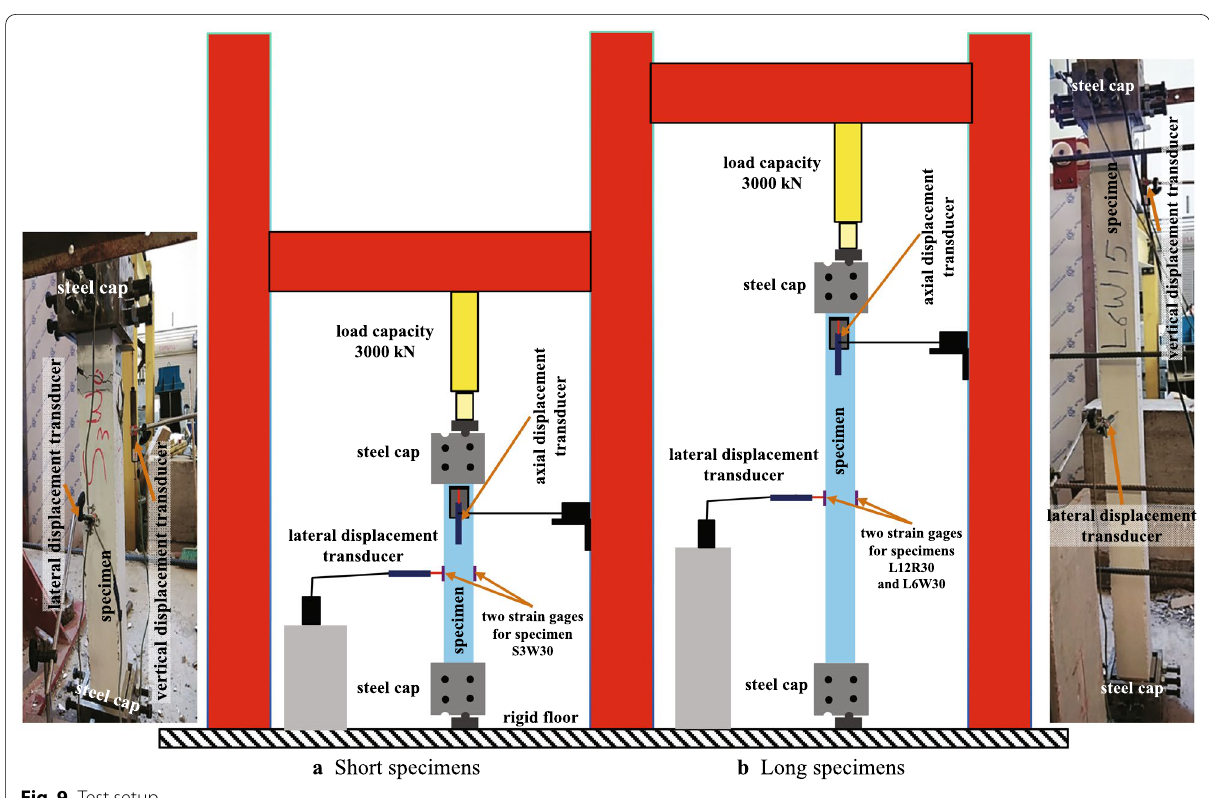
Fig. 9 Test setup